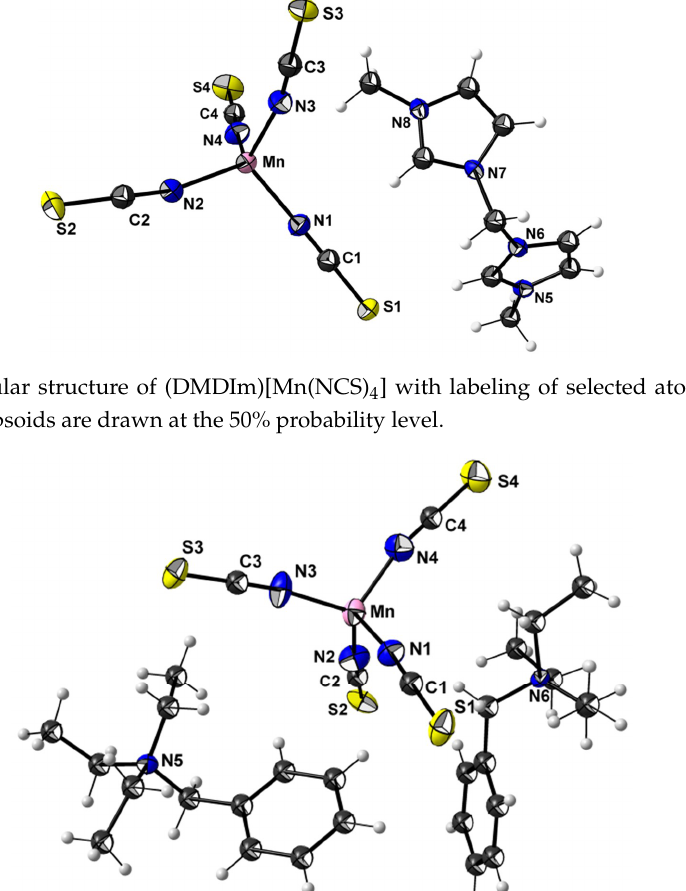
Figure 3. Molecular structure of ((Ph 3 P) 2 N) 2 [Mn(NCO) 4 ] with labeling of selected atoms. Thermal displacement ellipsoids are drawn at the 50% probability level. All atom distances and angles as well as all the other crystallographic and structure determination parameters are deposited with the CCDC (see Experimental Section). The bond distances and angles are found within the expected ranges. The cations and anions are located on general positions with the exception of the anion in {(Ph 3 P) 2 N} 2 [Mn(NCO) 4 ], which is located on the Wyckoff site 2 a with twofold rotational symmetry. In all cases the Mn atoms have a tetrahedral MnN 4 coordination environment with some deviations of the N-Mn-N angle from the ideal tetrahedral value. The ranges are 100.82(7)°–112.60(7)° in (DMDIm)[Mn(NCS) 4 ], 104.24(8)°–116.83(9)° in (BnEt 3 N) 2 [Mn(NCS) 4 ], and 104.2(1)°–113.9(1)° in {(Ph 3 P) 2 N} 2 [Mn(NCO) 4 ]. These values average at the ideal tetrahedral angle. 3.3. Thermal and Magnetic Properties